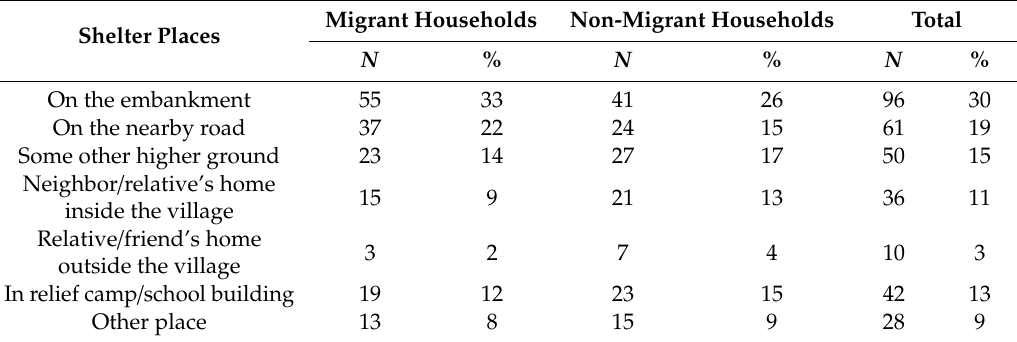
Table 5. Immediate shelters of the Aila a ff ected